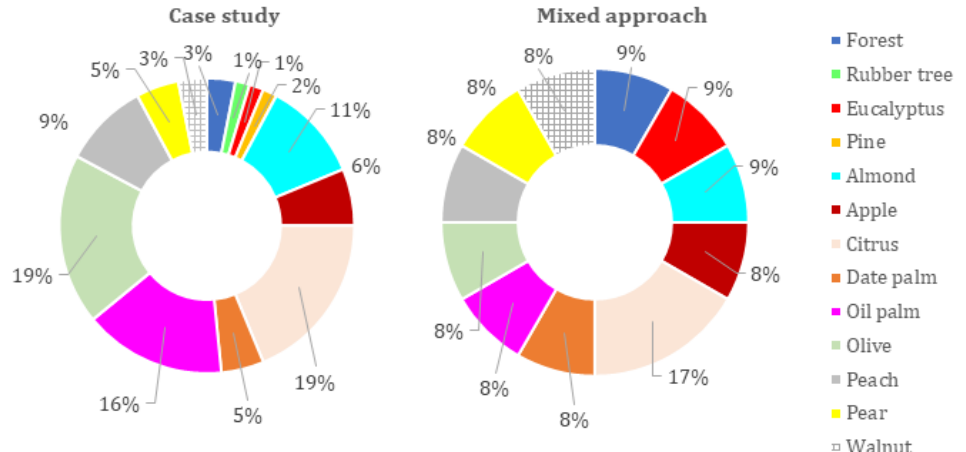
Figure 5. Distribution of tree type, expressed as a percentage of occurrences, in case studies and mixed approaches. The “citrus” label encompasses lemon and orange, and the “peach” label includes peach and nectarine.